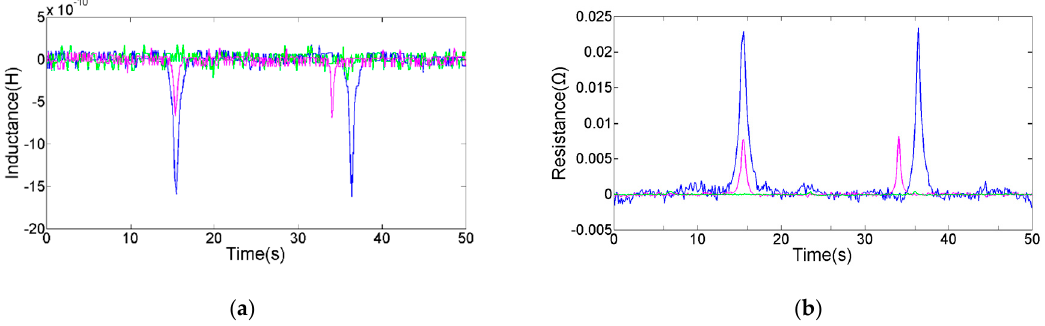
Figure 6. Comparison of detection results, the green line is the signal at 0.2 MHz, the red line is the signal at 1.0 MHz, and the blue line is the signal at 2.0 MHz: ( a ) the inductance signal of a 120 μ m copper particle; ( b ) the resistance signal of a 120 μ m copper particle.